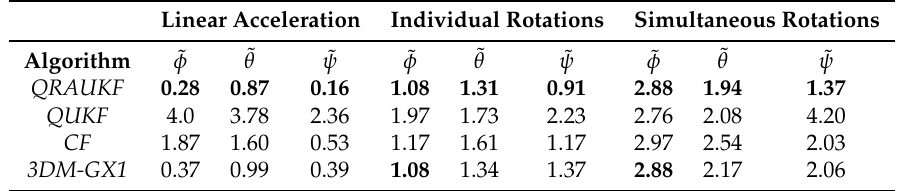
Table 2. Root Mean Square Error (RMSE) in degrees for disturbance scenarios (iii), (iv), and (v). The lowest RMSE results are highlighted in